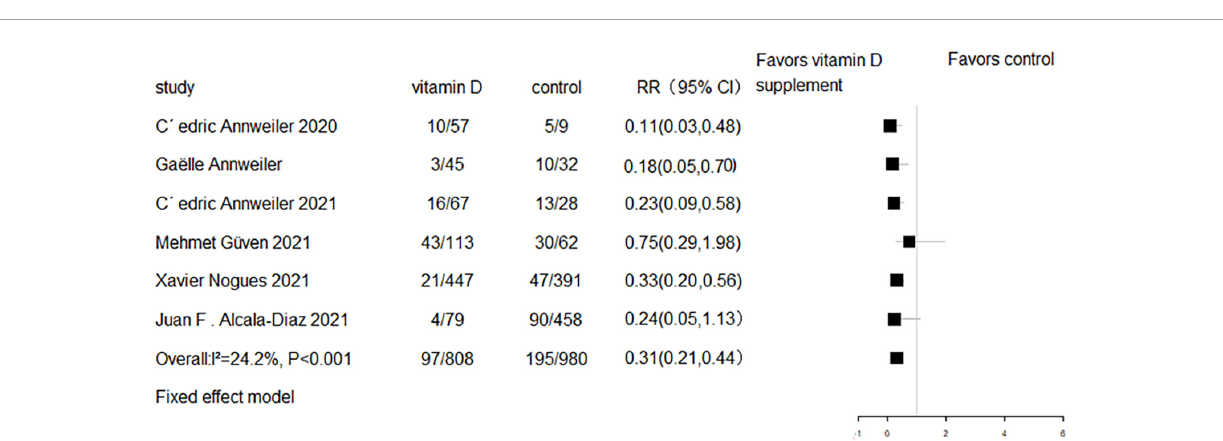
Frontiers in Nutrition